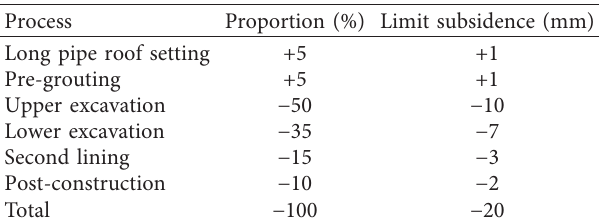
Figure 13: Connection of lock pin anchor pipe on-site. Table 3: Limit subsidence of each